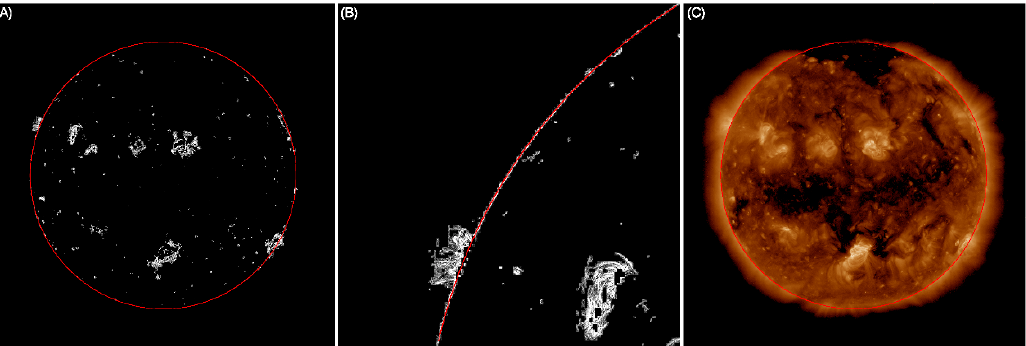
Figure 5. The fitted circle boundary using the least square circle fitting ( A , B ) is a partially enlarged view of ( A , C ) the fitted boundary in the original solar EUV image.